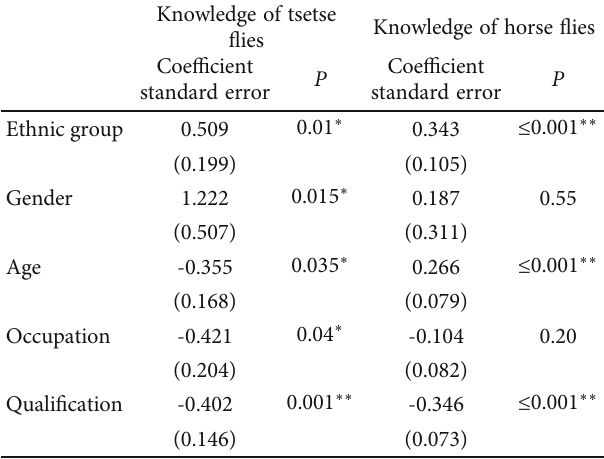
Table 3: Association between sociodemographic variables and knowledge of African animal trypanosomiasis vectors in The Gambia,